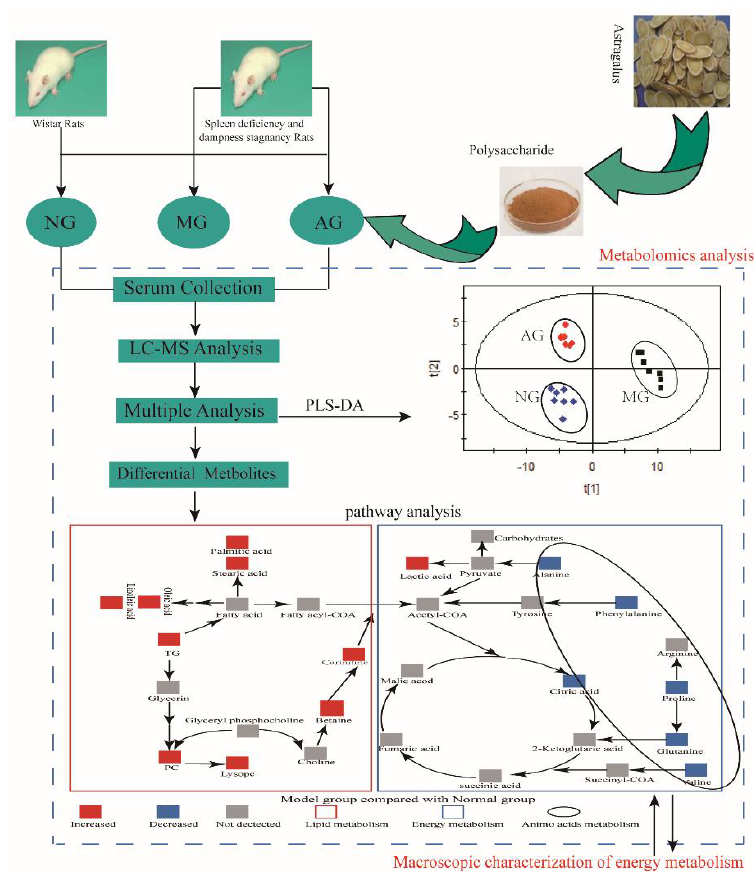
Figure 5. Experimental flow chart of the overall behavioral and serum metabolomic approaches.